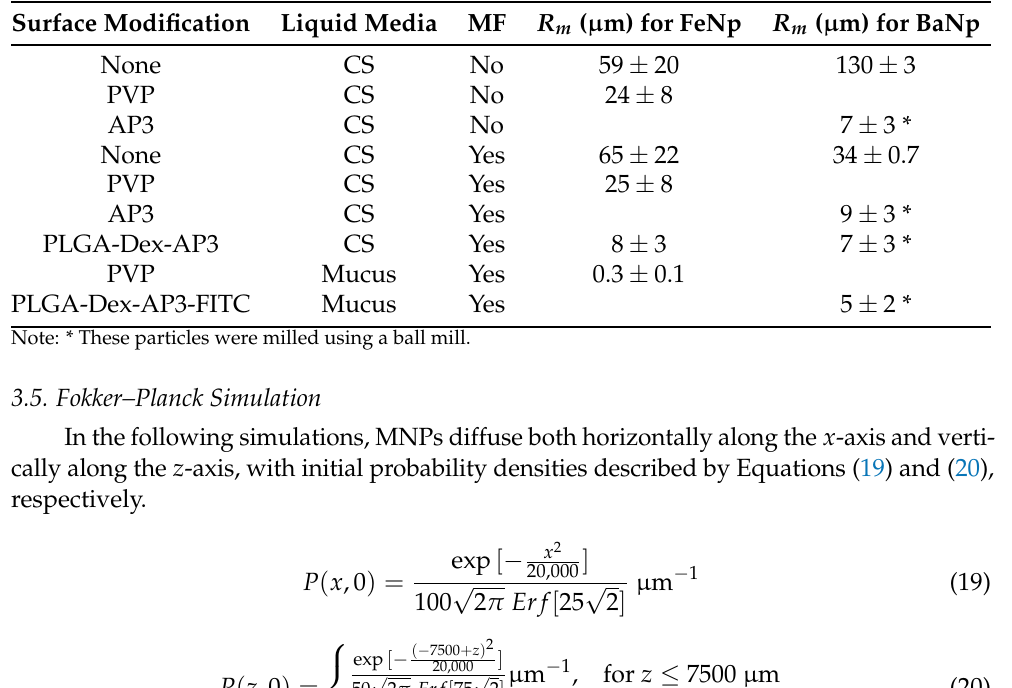
Table 7. Surface modification effects on R m , with gravity or MF, in corn syrup (CS) and mucus. Magnetic Radius R m was estimated from r m with values and errors listed in Table 1, by Equation (9). Uncertainty in R m was propagated from errors by the method of Section